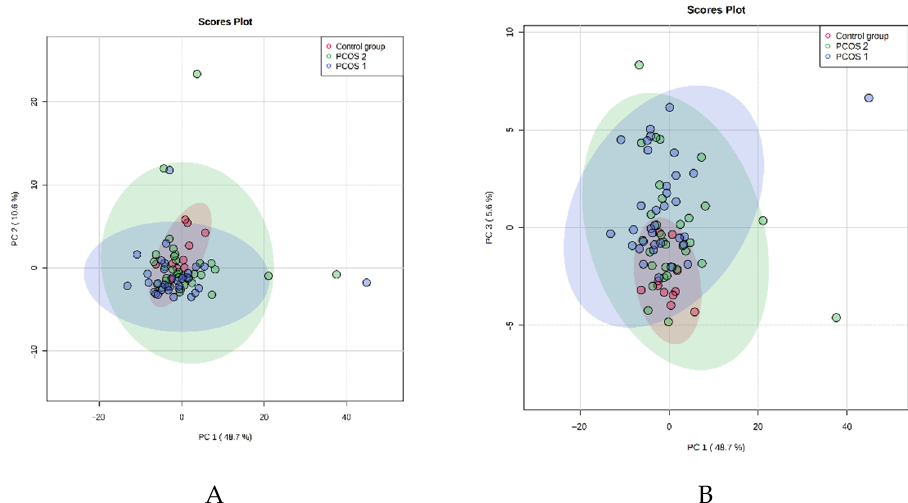
Figure 2. The unsupervised multivariate principal component analysis (PCA) of the studied metabolites in the PCOS-1, PCOS-2, and control groups. The plots represent the first principal component (PC1) against the second principal component (PC2) ( A ) and the first principal component (PC1) against the third principal component (PC3) ( B ).